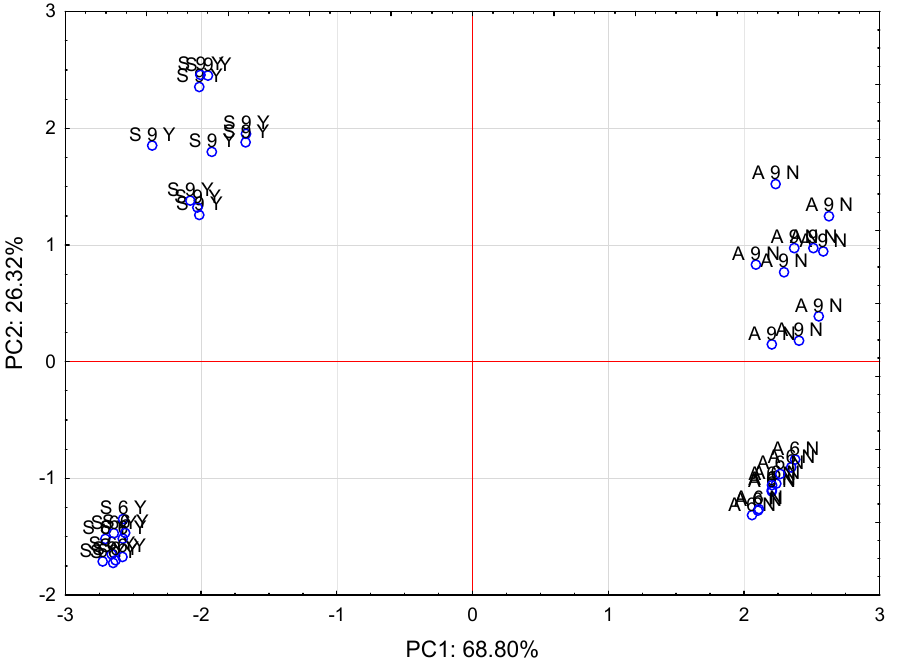
Figure 4. Plot of the PCA analysis results for two main components (PC1, PC2) obtained from seven parameters analysed in the investigated cases (A6N— I. aphylla collected in June, no foraging; A9N— I. aphylla collected in September, no foraging, S6Y— I. sibirica collected in June, foraging, S9Y— I. sibirica collected in September,